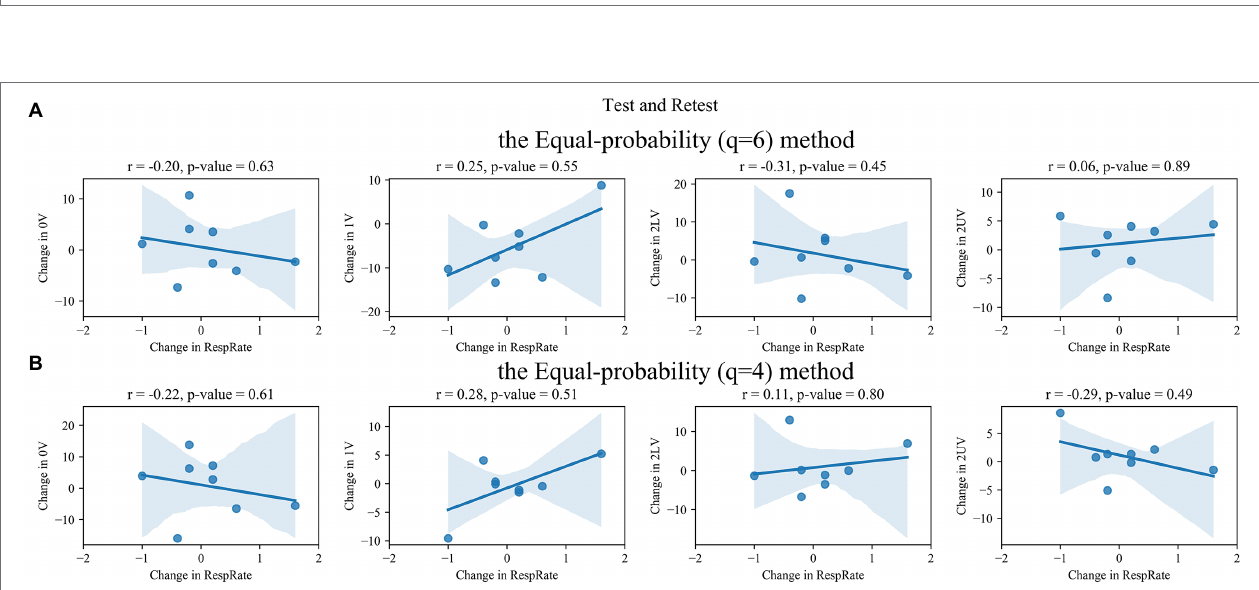
FIGURE 6 | Correlation between retest–test differences in SymDyn indices and differences in respiratory rate (RespRate): (A) the Max–min method, (B) the σ -method.